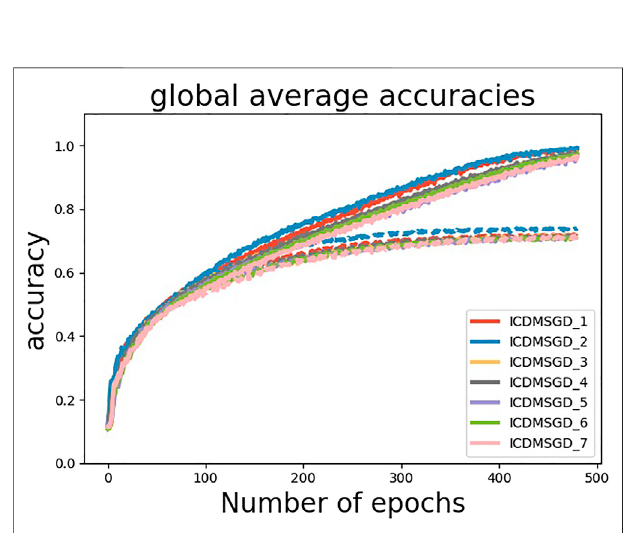
FIGURE 6 | Performance of i-CDMSGD for different τ values (Dash lines represent test accuracy and solid lines represent training